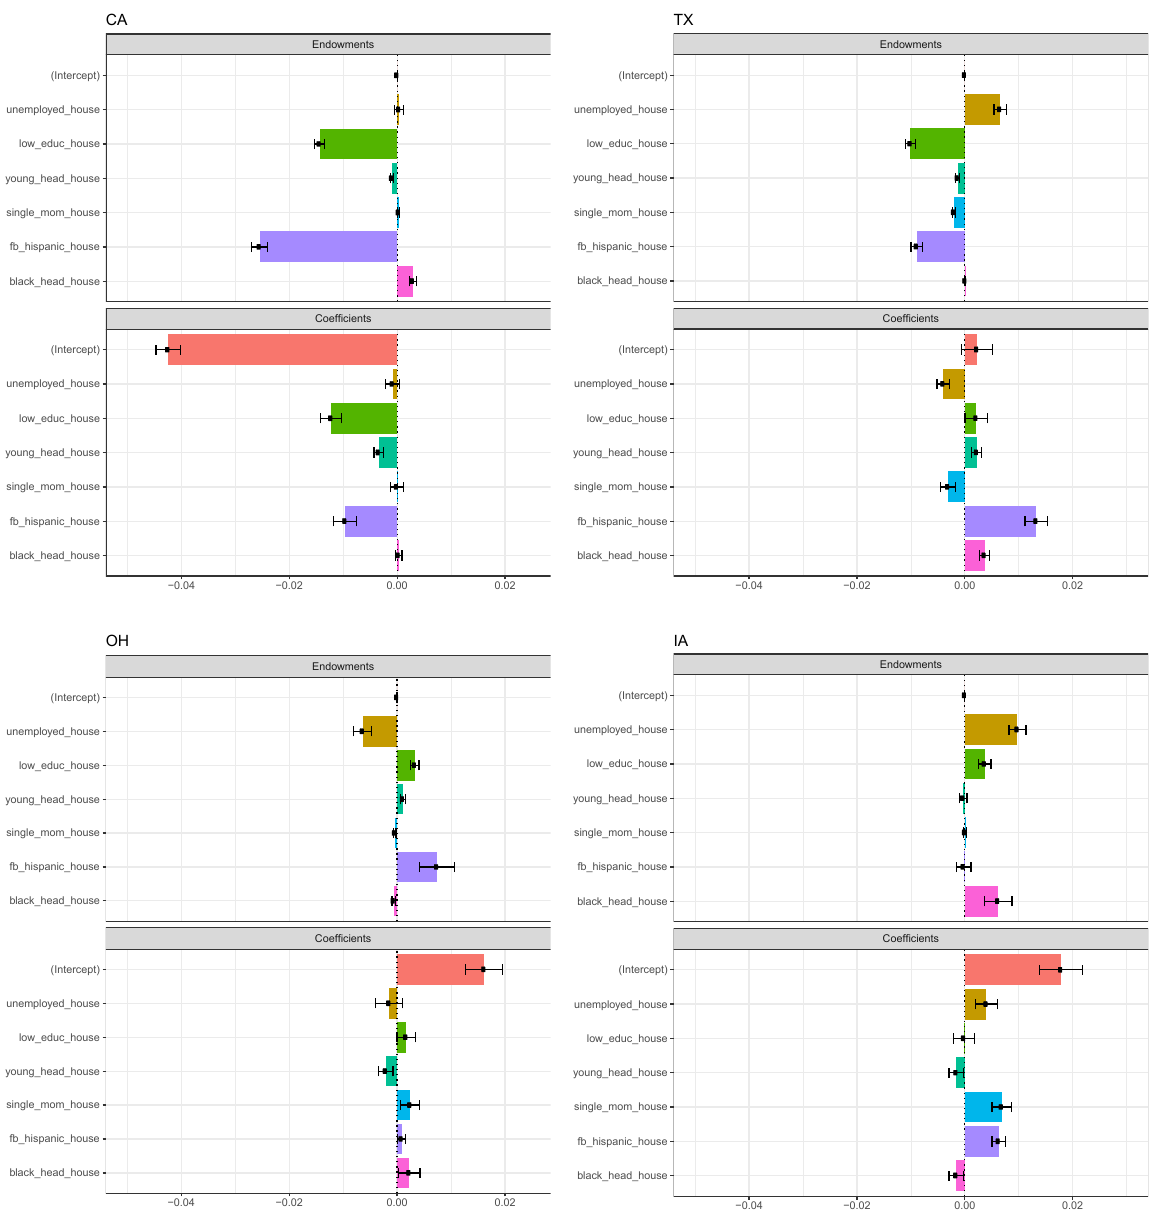
Figure 11: Decomposition of poverty differences for select